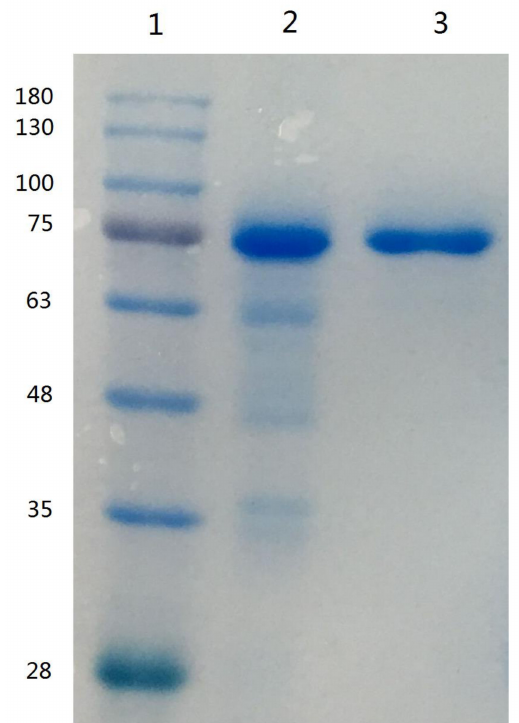
Figure 1. SDS-PAGE of camel lactoferrin obtained from camel milk. Lane 1, molecular weight standards; lane 2, lactoferrin from bovine milk; lane 3, purified camel